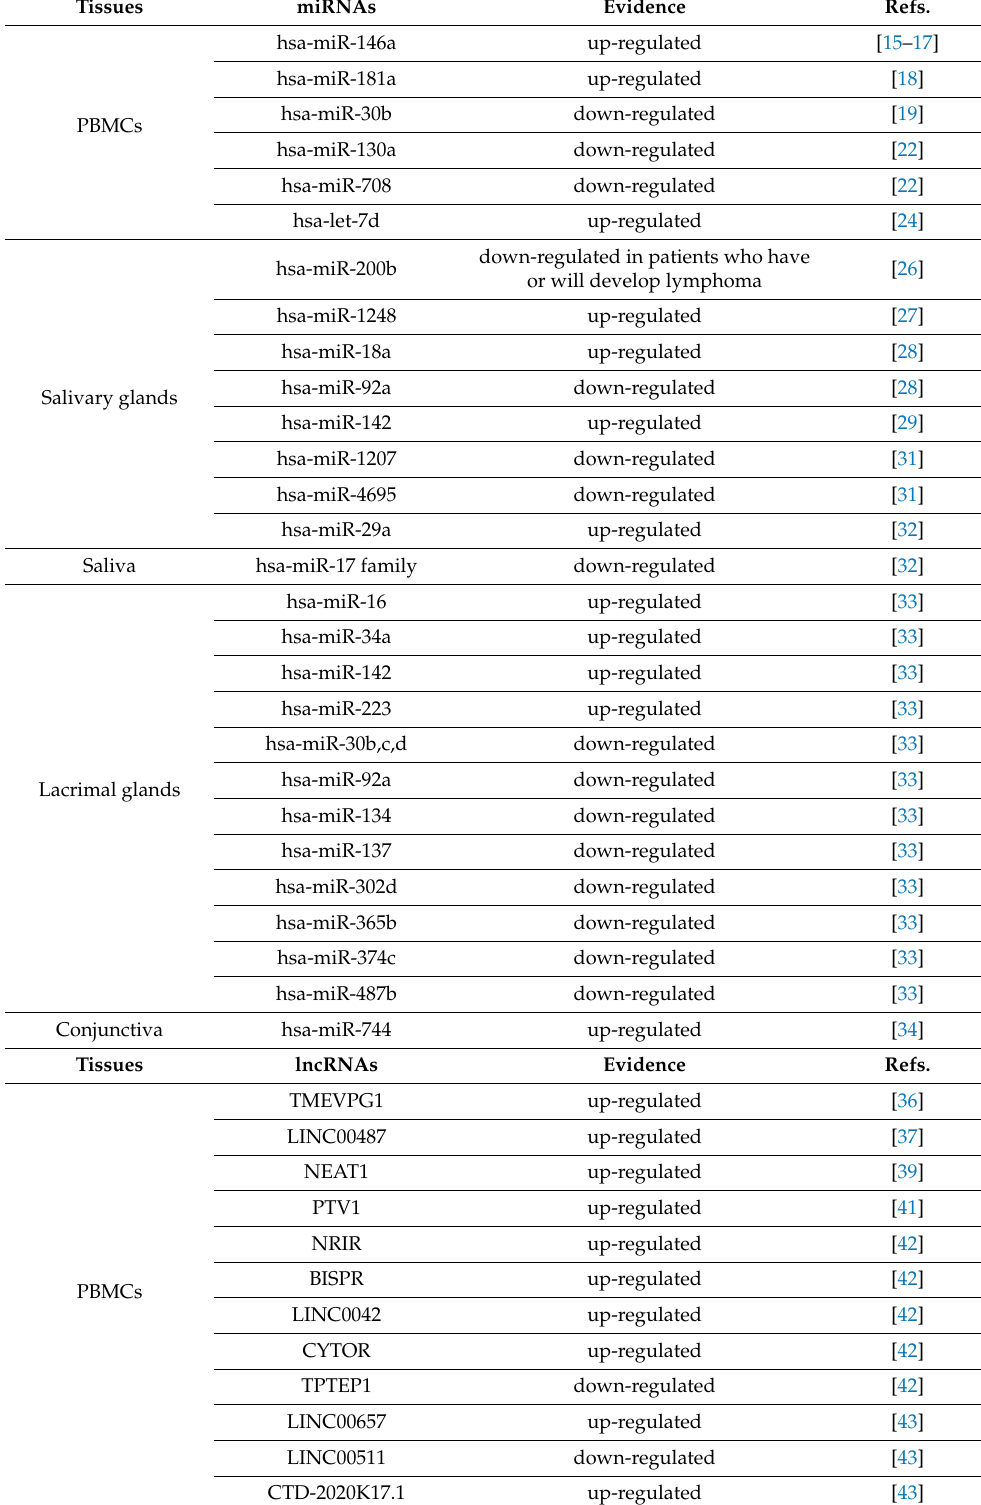
Table 1. List of principal miRNAs and lncRNAs potentially involved with SS